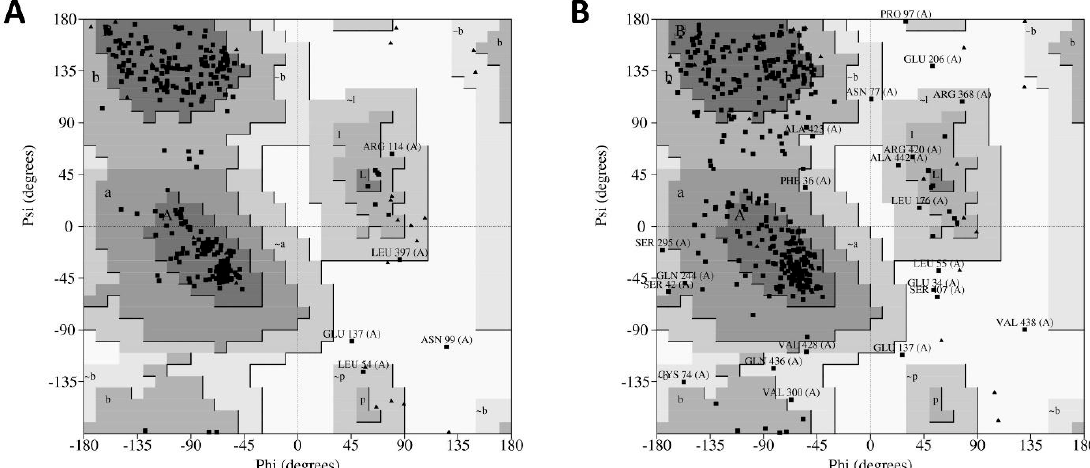
Figure 5. PROCHECK (Program to check the stereochemical quality of protein structures) results of modelled hDKC1 using the generated models from I-TASSER. ( A ) Ramachandran plot for hDKC1 homology model; ( B ) Ramachandran plot for hDKC1 ab initio model. Residues in most favored regions (A, B, L), residues in additional allowed regions (a, b, l, p) and residues in generously allowed regions (~a, ~b ~l, ~p).